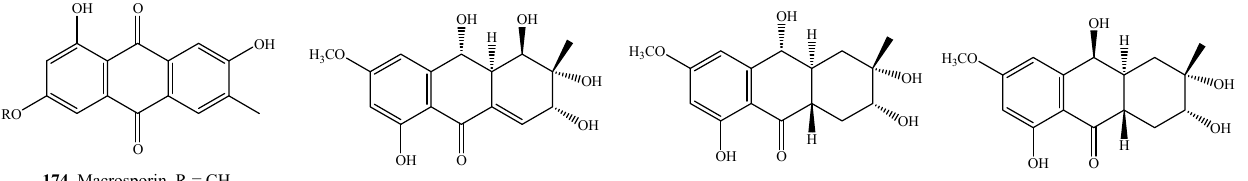
Figure 10. Anthraquinones isolated from Alternaria